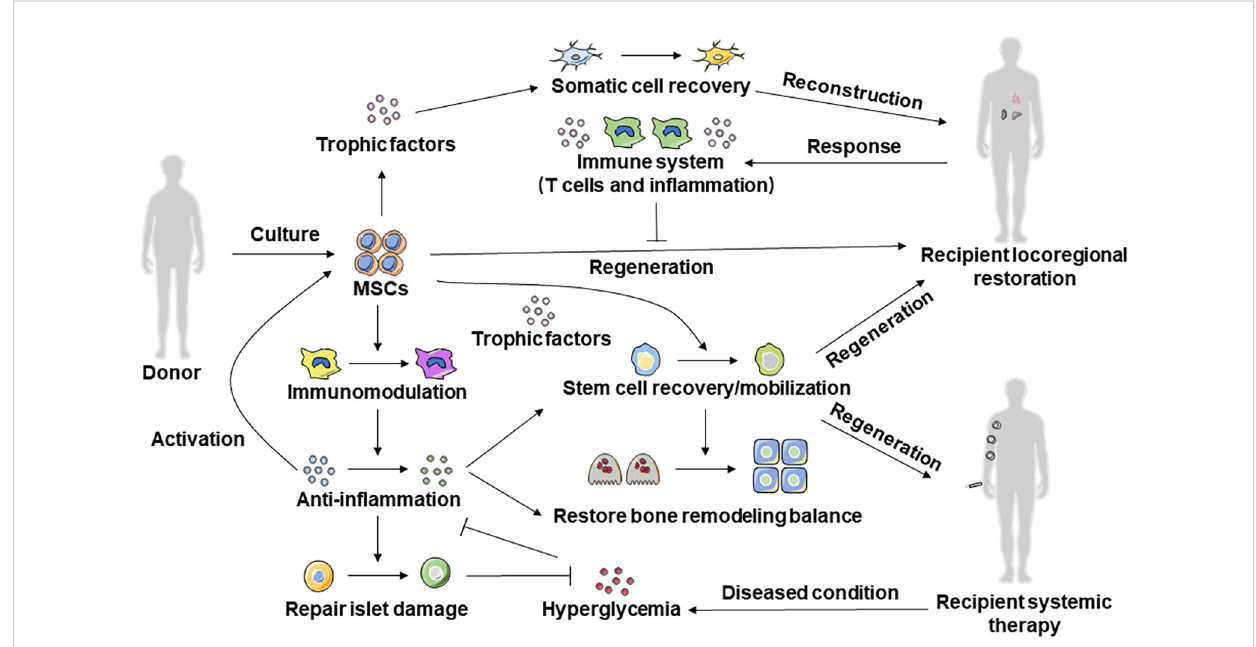
FIGURE 2 Cell-host interplay determines ef fi cacy of MSC therapy. Systemic infusion and local transplantation of MSCs can secrete anti-in fl ammatory factors to target cells through immunomodulatory ability to repair damaged tissues and maintain local tissue immune homeostasis. A variety of cytokines and EV forms of tissue trophic factors can be secreted through the paracrine effect to promote mobilization, proliferation, and anti-apoptosis, to improve the microenvironment of the recipient and inhibit the development and progression of